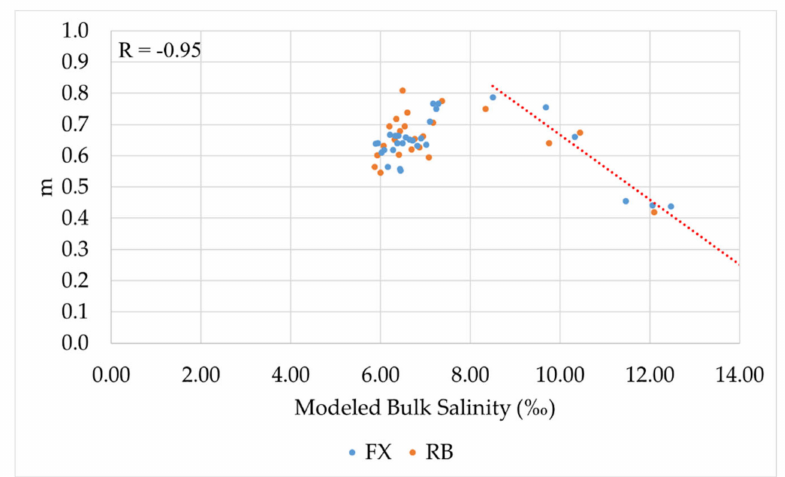
Figure 11. Temporal evolution of m with estimated ice bulk salinity. Red trend line is included for values in the range sensitive to ice salinity. R is the correlation coe ffi cient of linearly regressed